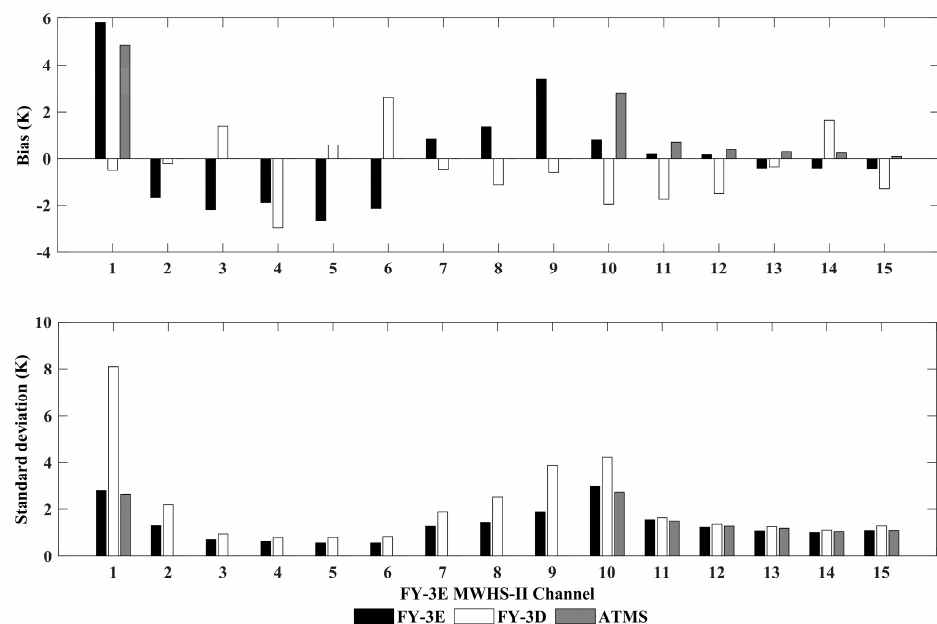
Figure 5. The same as Figure 4, but for FY-3E MWHS-II (black), FY-3D MWHS-II (white) and ATMS (gray). x-coordinate is the channel number of FY-3E MWHS-II.